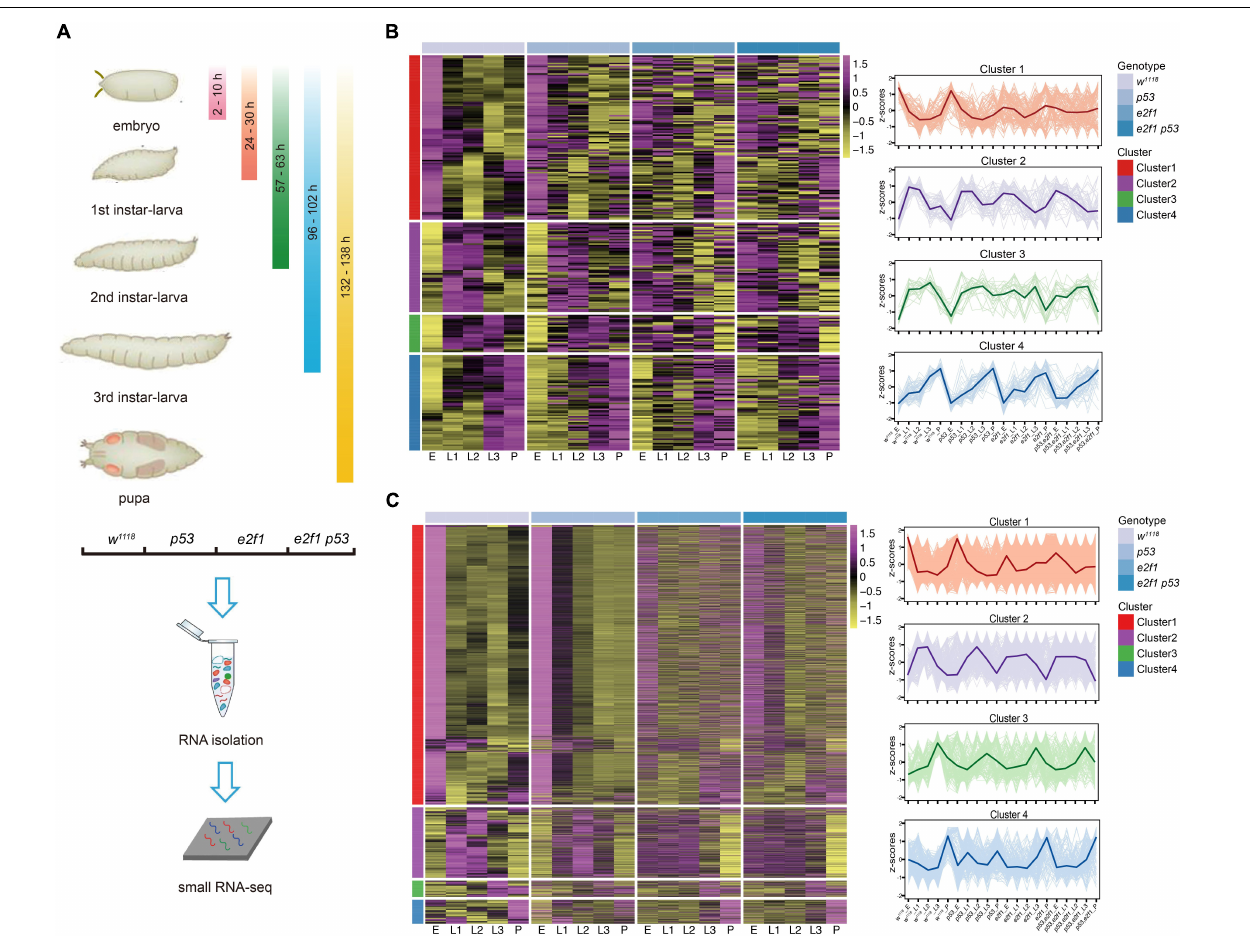
FIGURE 1 | Clustering of Drosophila miRNAs and piRNAs during development. (A) Schematic illustration of experimental design and time-points for samples collection. Heatmap of the normalized expression level of miRNAs (B) and piRNAs (C) in the 4 clusters in w 1118 , p53 mutant, e2f1 mutant and e2f1 p53 double